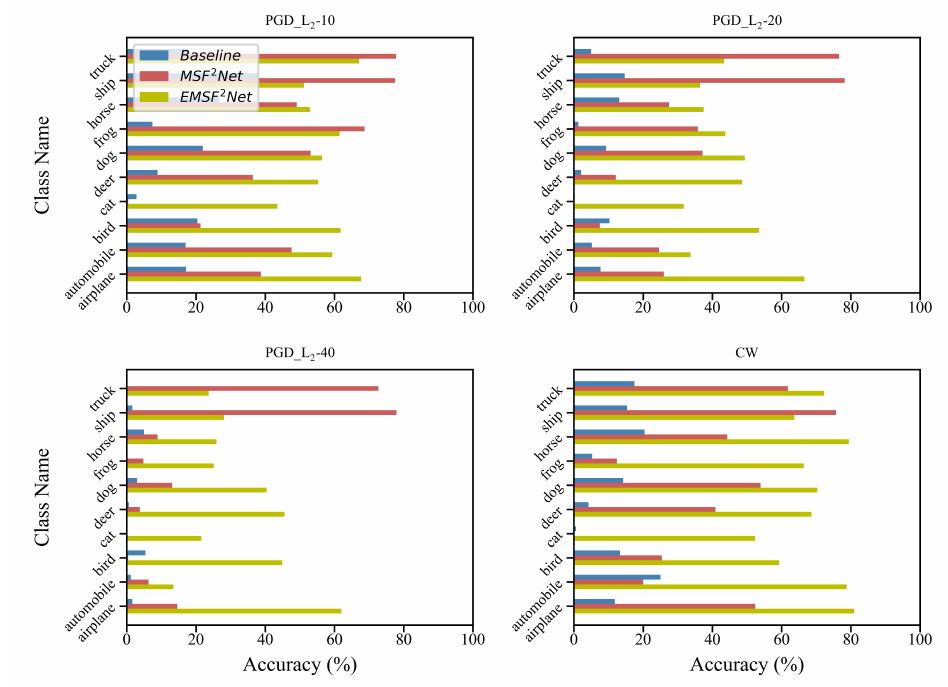
Figure 5. Robust accuracy under L 2 -norm attacks of the three methods on each class of the CIFAR-10 dataset. The X-axis and Y-axis of each sub-figure represent the robust accuracy and class name of CIFAR-10,